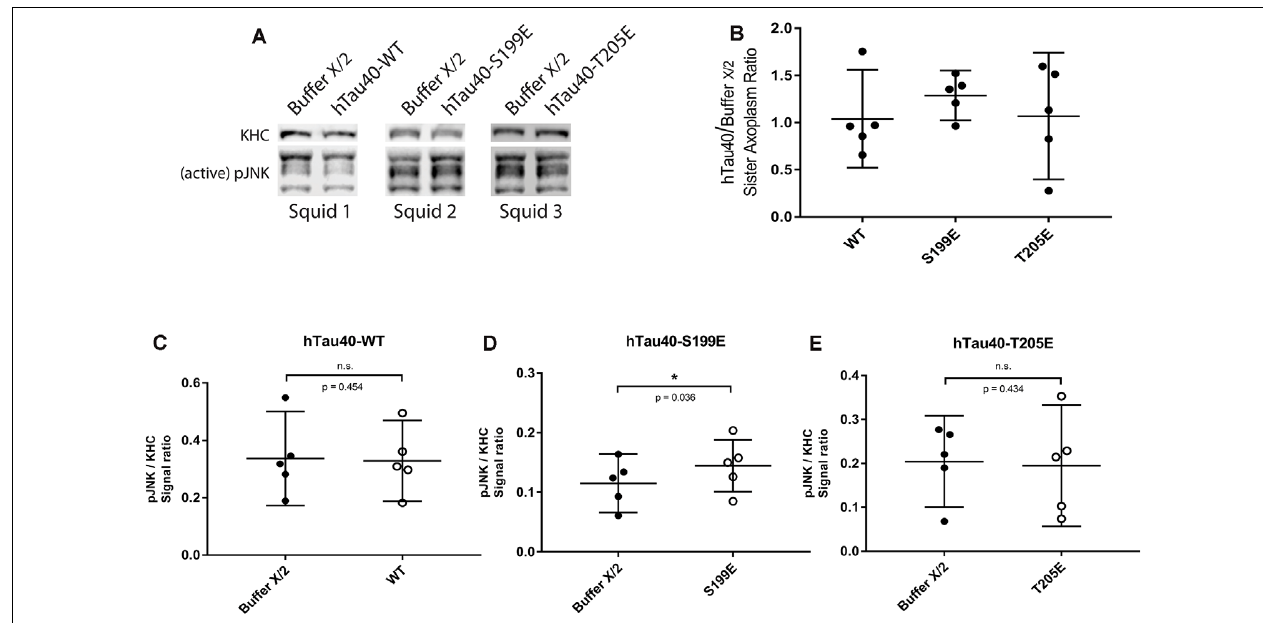
FIGURE 5 | hTau40-S199E activates pJNK. (A) Representative images showing immunoblots of lysates from three “sister” axoplasm pairs, each pair obtained from a single independent squid (squids 1–3; Kang et al., 2016). Each “sister” axoplasm was perfused with either Buffer X (control) vs. hTau40-WT monomers, Buffer X vs. hTau40-S199E monomers, or Buffer X vs. hTau40-T205E monomers. After a 50-min incubation, axoplasm lysates were prepared, separated by SDS–PAGE and immunoblots revealed using antibodies that recognize phosphorylated-active forms of JNK kinases (pJNK), and with a monoclonal antibody that recognizes heavy chain subunits of the motor kinesin-1 (KHC, internal control for total axoplasmic protein loading). (B) Quantitation of pJNK immunoblot signal (normalized to KHC) for “sister” axoplasm pairs (hTau40/Buffer X/2; n = 5 axoplasm pairs for each hTau40 pseudophosphorylated protein). (C–E) Quantification of pJNK immunoblots. Perfusion of hTau40-S199E significantly increased pJNK activation compared to Buffer X ( n = 5; p = 0.037; D ) whereas hTau40-WT ( n = 5; p = 0.453; C ) or hTau40-T205E ( n = 5; p = 0.434; E ) had no overall effect. pJNK signal intensity was normalized to kinesin heavy chain (KHC). All data are presented as mean ± 95% confidence